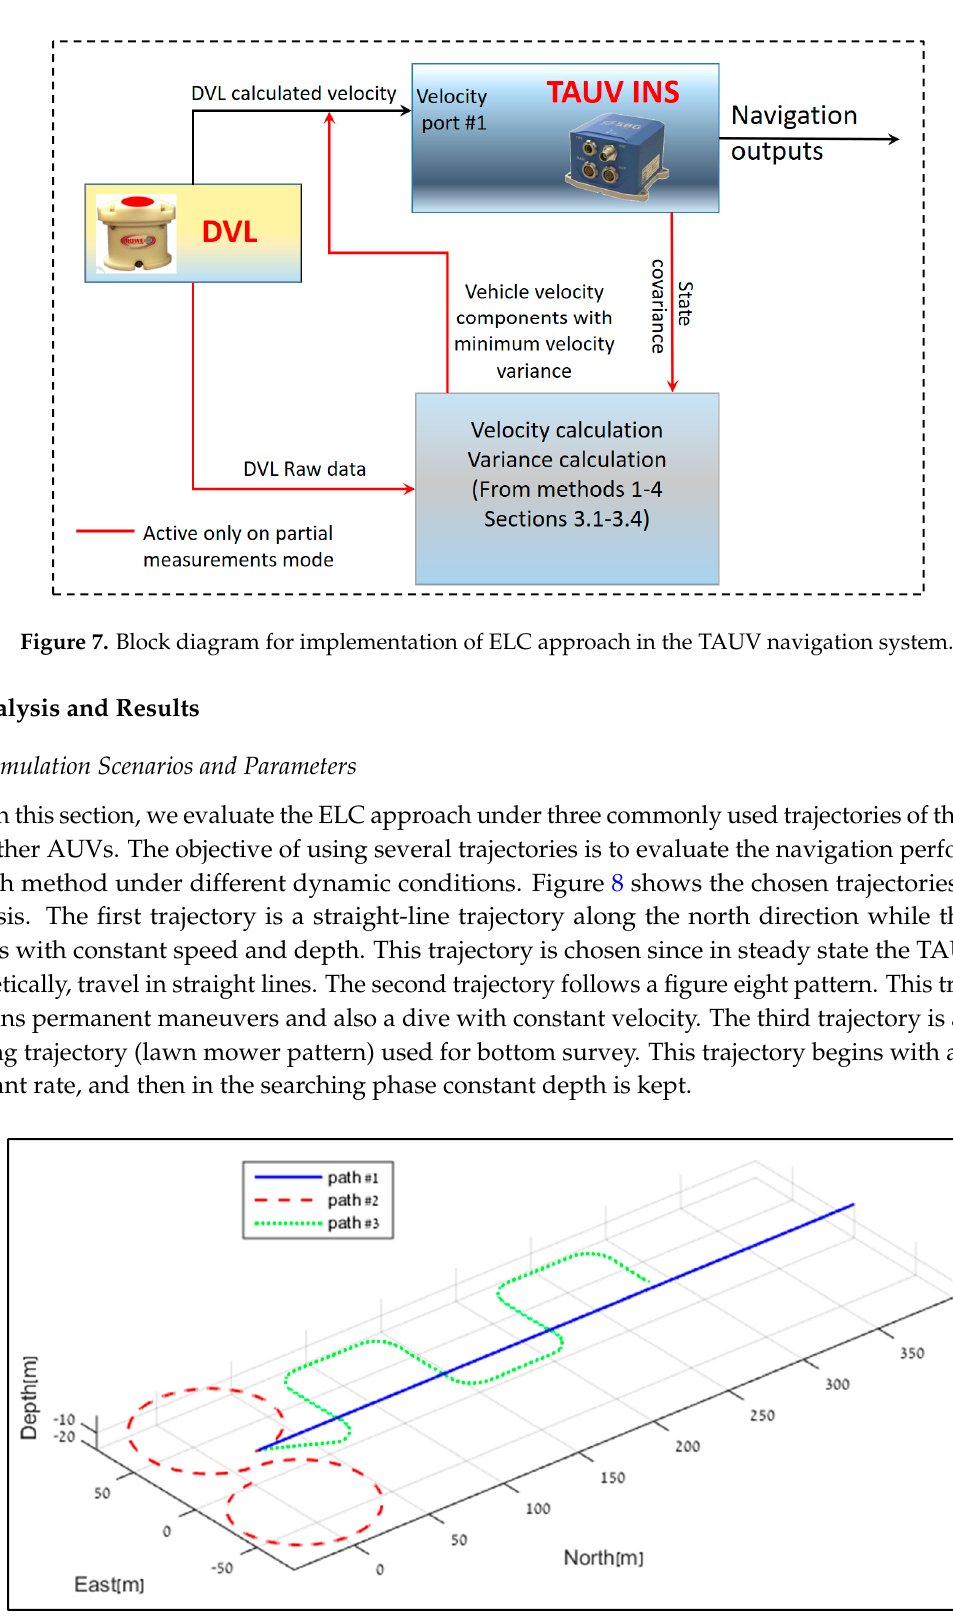
Figure 8. Simulation trajectories used to examine the ELC approaches.